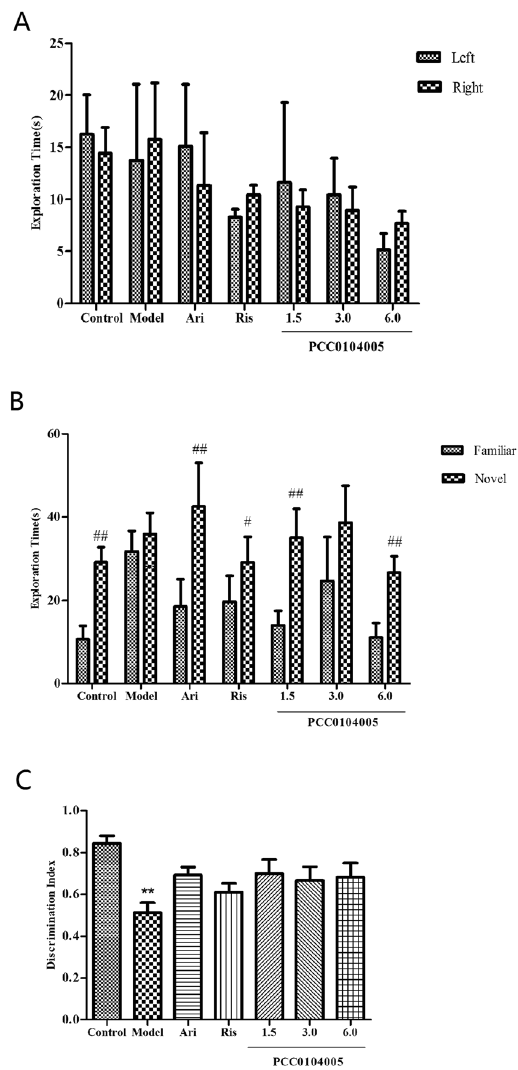
Figure 6. The effect of PCC0104005 on MK-801-induced NOR deficit in rats. SD rats were administered an oral dose of vehicle alone PCC0104005 (1.5, 3.0, or 6.0 mg/kg), aripiprazole (Ari, 1.5 mg/kg) or risperidone (Ris, 0.2 mg/kg) for 28 days. Beginning on the 15th day, intraperitoneal injections of 0.9% saline or MK-801 (0.3 mg/ kg) to 28th day. On the day of testing, each rat was placed in the NOR chamber and exposed to two identical objects (Left and Right) for a period of 10 min (Acquisition Trial). Rats were then returned to their home cage for an inter-trial interval (ITI) of 1.5 h, the entire box was cleaned, and both objects removed. One was replaced with an identical familiar copy and one was replaced with a novel object. Following the ITI, rats were returned to the apparatus and allowed to explore the familiar and novel objects in the test box during a 10-min retention trial (Retention Trial). ( A ) Acquisition Trial: A preference for the left or the right object was not observed. ( B ) Retention Trial: With the exception of the model group and 3.0 mg/kg PCC0104005 group, the other groups showed significant increases in the exploration of novel object compared to the familiar object ( # P < 0.05, ## P < 0.01). Data are expressed as means ± SEM (n = 10 per group). ( C ) Discrimination Index: All drug administration groups exhibited an increase in the MK-801-induced reduction in DI. ## P < 0.01: significant reduction in DI compared to the control